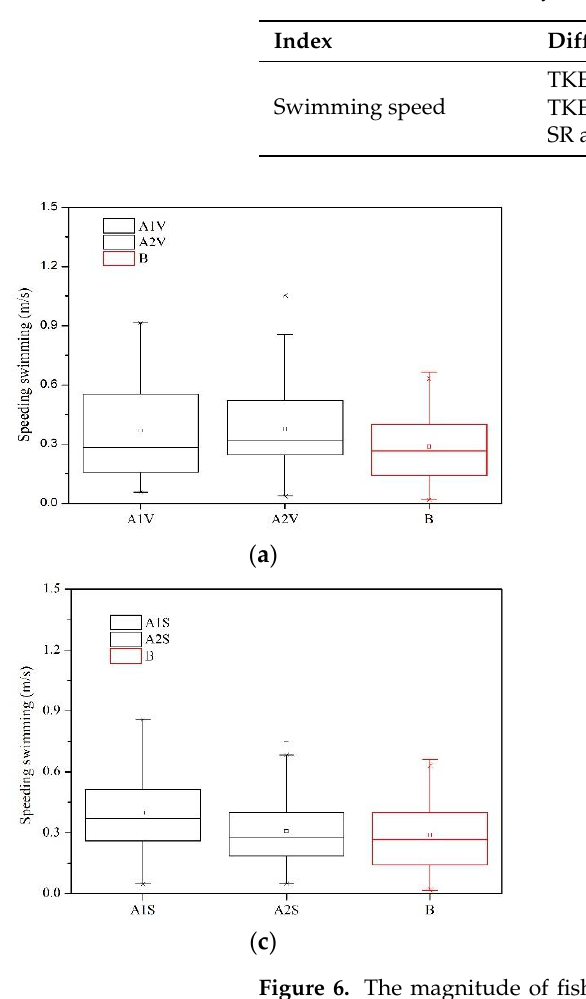
Table 2. Kruskal–Wallis analysis on fish swimming speeds under different hydraulic conditions.